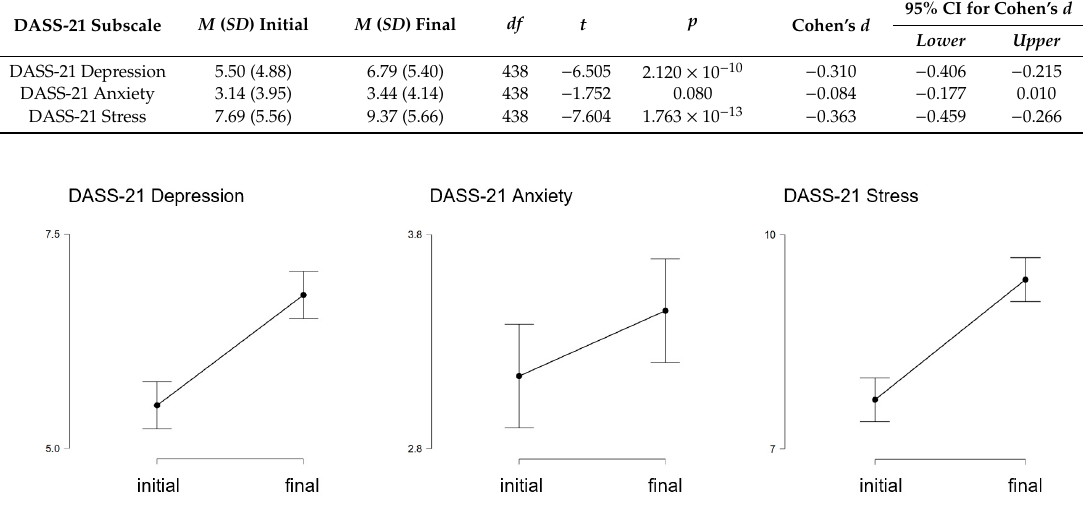
Figure 1. Descriptive plots comparing depression, anxiety, and stress levels, as measured with the DASS-21, between the initial and the final period of the